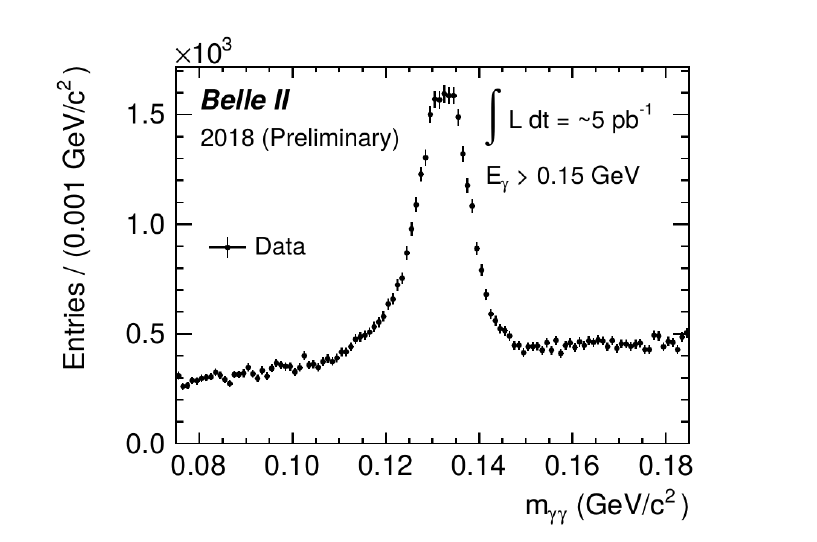
Figure 2. The invariant mass distribution m γγ for π 0 candidates from Belle II first collision